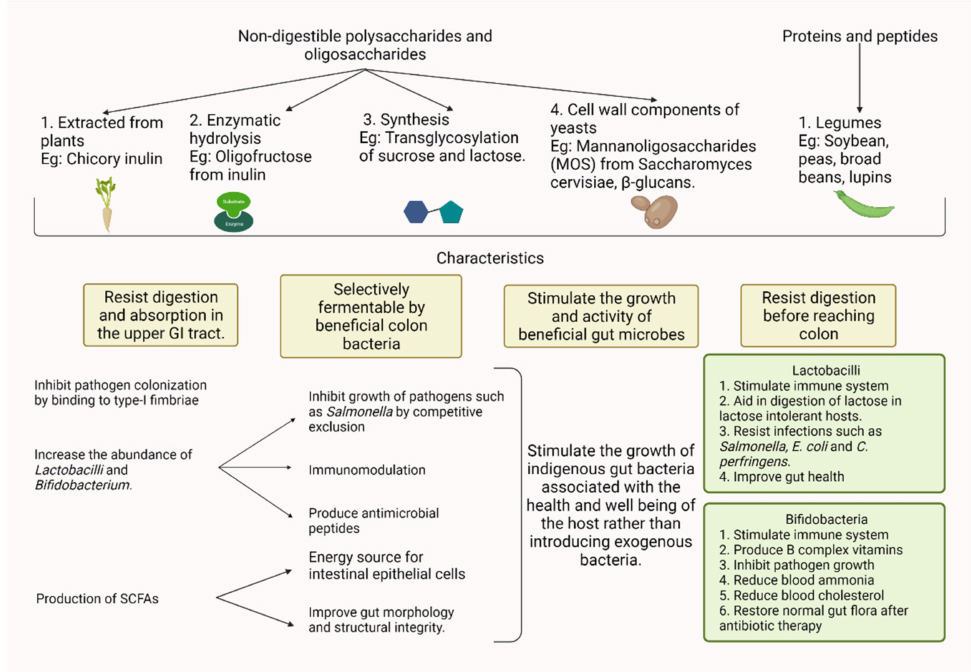
Figure 4. Prebiotics are polysaccharides or oligosaccharides capable of resisting digestion and absorption in the proximal intestine and is selectively fermented by caecal and colonic bacteria such as Lactobacillus and Bifidobacterium , thus increasing their abundance in host gut. Prebiotics act as decoy receptors for the binding of pathogens, thus preventing their attachment to the host intestinal cells. Prebiotics also serve as a substrate for the production of SCFAs which serve as energy source for the intestinal epithelial cells. Created with Biorender.com (26 April